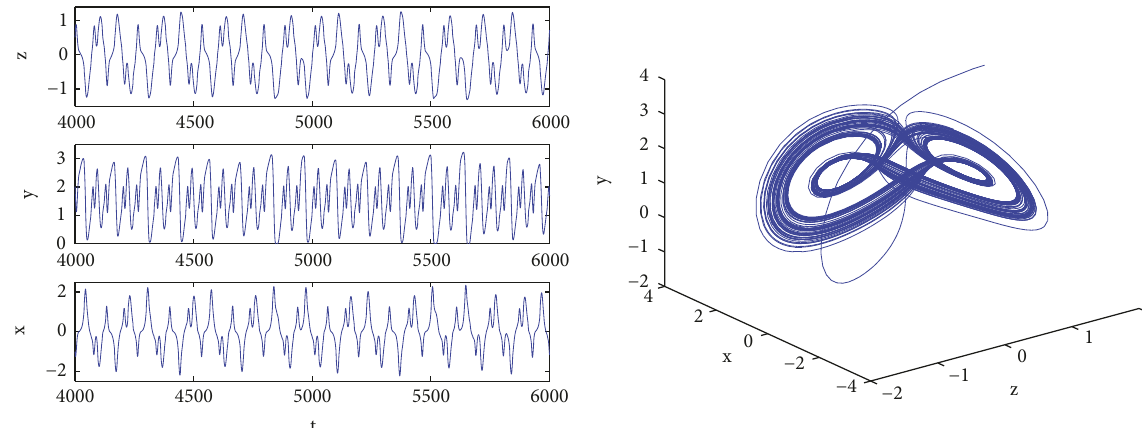
Figure 11: The equilibrium is unstable and chaos exists for system (52) with 𝜏 1 = 𝜏 2 = 𝜏 3 = 0.1 .